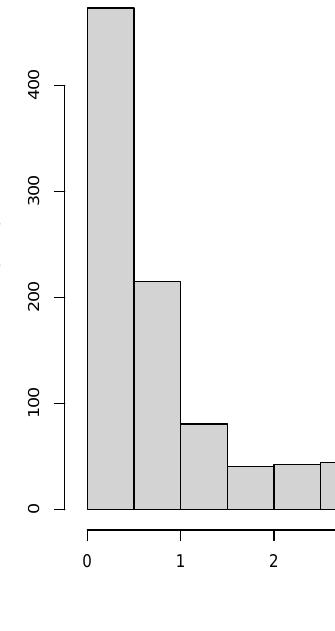
Figure 14. Feasibility index values computed by FE and the metamodel.